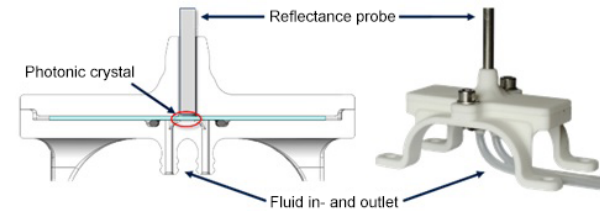
Figure 5. Scheme (left) and photo (right) of the custom-built fluid measurement cell.